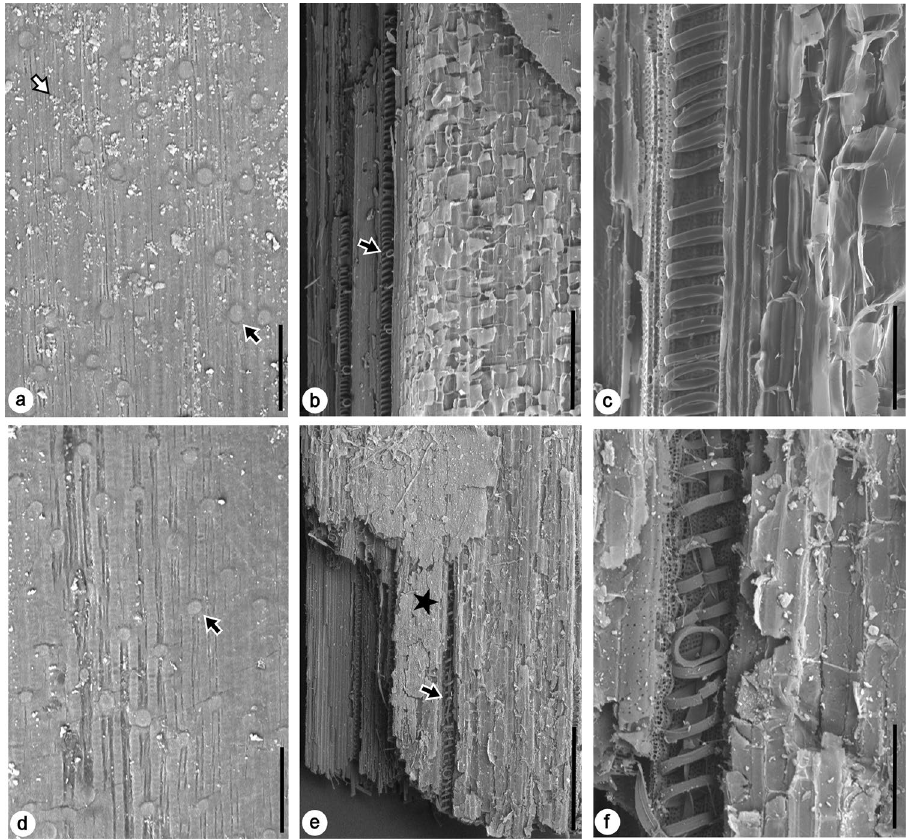
Figure 3. SEM photographs of modern ( Phragmites australis ) and ancient ( Phragmites sp. ) culms. ( a – c ) are modern P. australis from Milan Castle (Site 8), and ( d – f ) are Phragmites from the Tang Dynasty Sunji beacon tower (Site 12). ( a ) and ( d ) are external views showing typical culm epidermal features with two distinct cell types—the elongated rectangular cells and the short silica cells (indicated by black arrows with white margins). The modern sample is covered with epicuticular wax crystals (white arrow with black margin), whereas the ancient sample only has some wax remaining. Scale bar = 50 μm. ( b ) and ( e ) are internal views. The inner membranes are indicated by stars. Black arrows with white margins indicate vessel elements. Ancient sample shows certain degree of decay as indicated by cracked membranes and unclear cell boundaries. Scale bar = 500 μm. ( c ) and ( f ) are also internal views, showing vessel elements with lignified spiral secondary walls and surrounding parenchyma cells. Except for certain degree of degradation in the ancient sample, the shape and size of both vessel elements and parenchyma cells are almost identical. Scale bar = 100